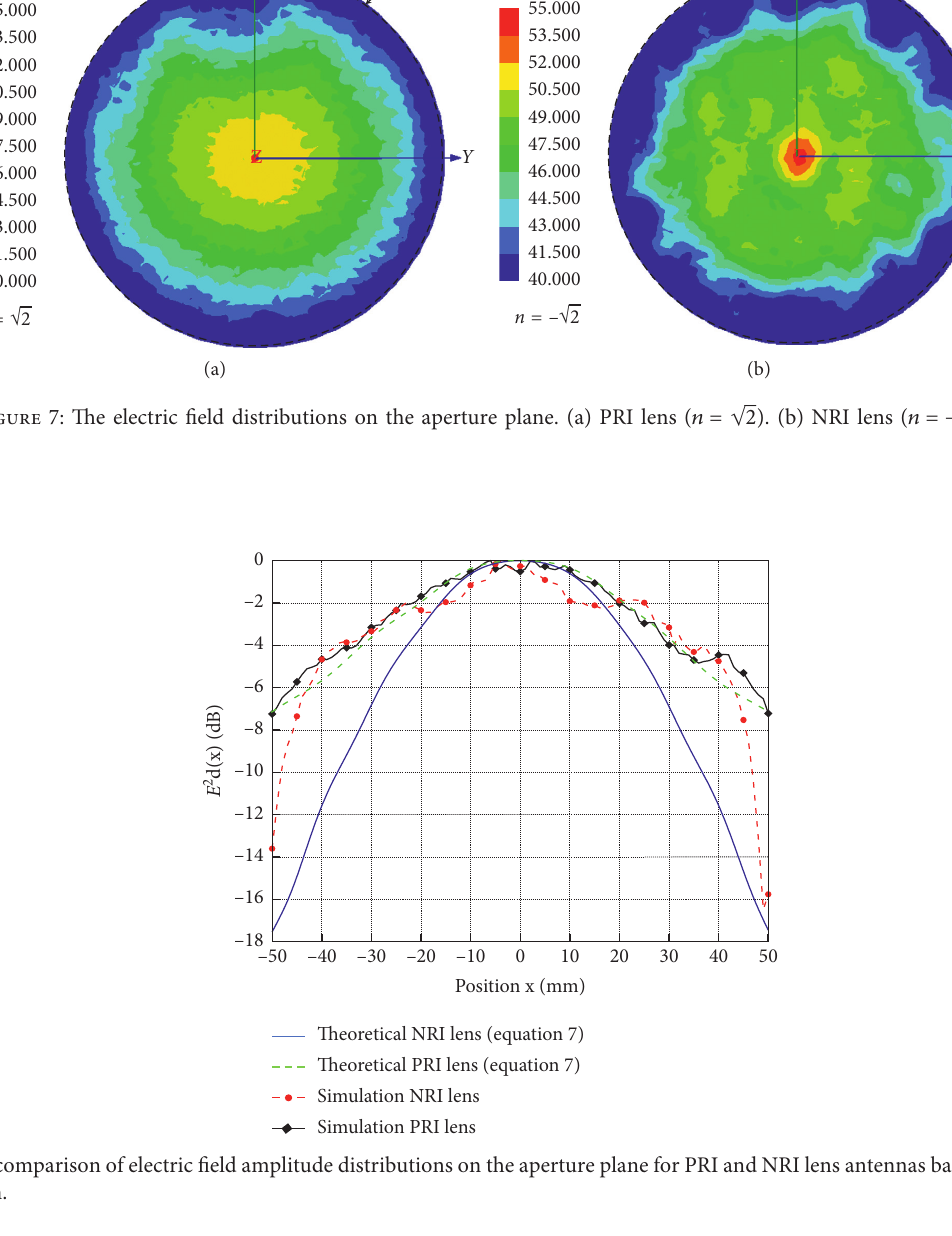
Figure 8: The comparison of electric field amplitude distributions on the aperture plane for PRI and NRI lens antennas based on theoretical and